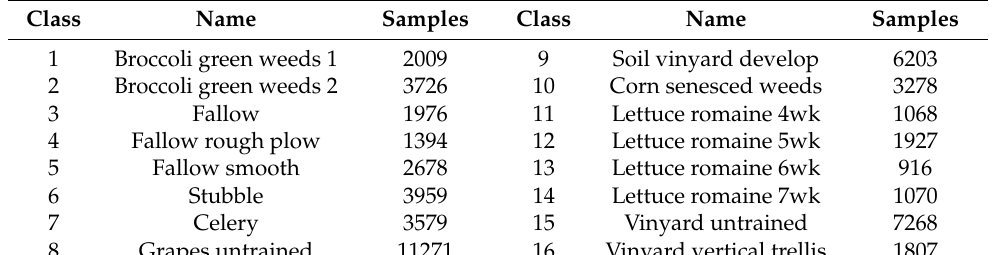
Table 3. Sixteen ground ‐ truth classes of the Salinas data set.